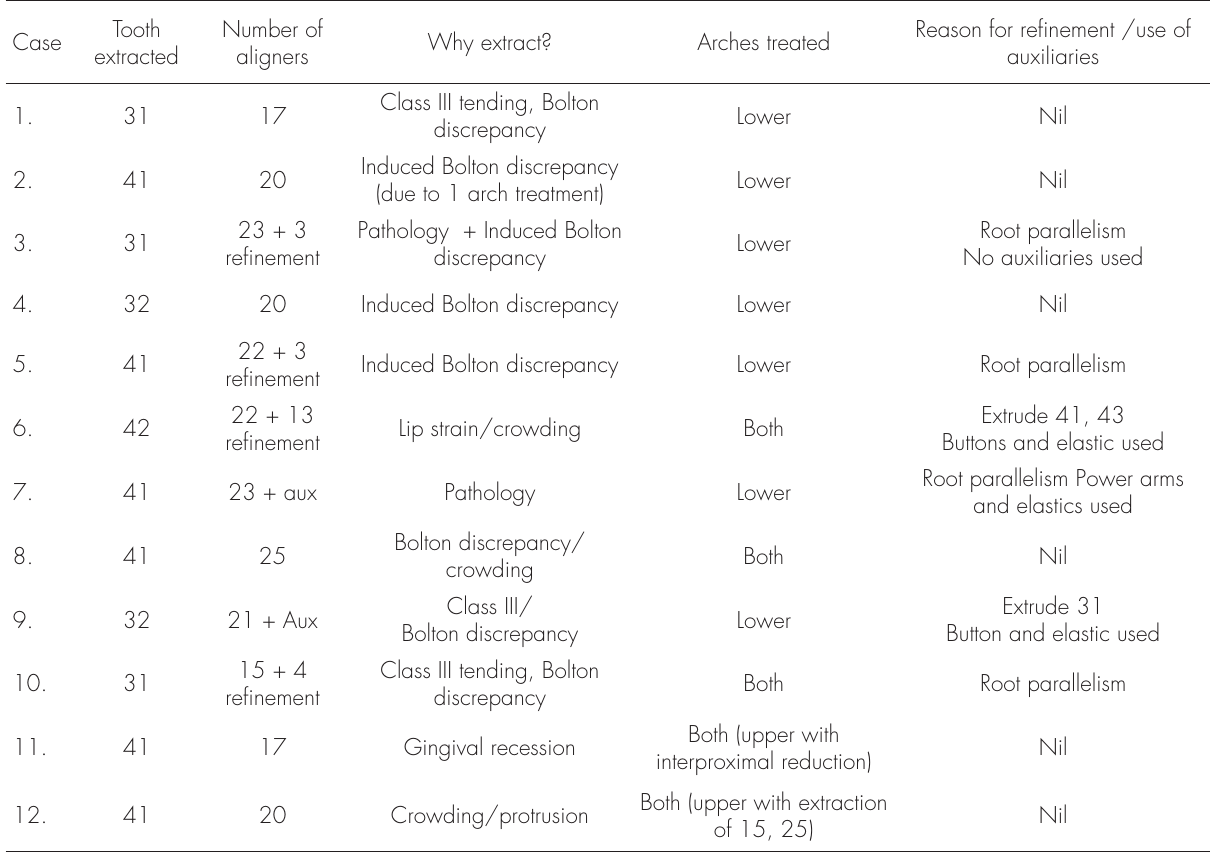
Table I. Results of the 12 patients treated with the Invisalign